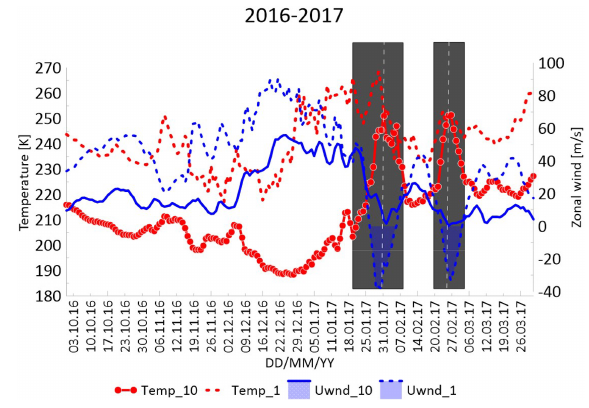
Figure 2. Zonal mean of the zonal wind at 10hPa (blue solid line) and 1hPa (blue dotted line) and zonal mean temperature at 10hPa (red solid line) and 1hPa (red dotted line) obtained from the ERA5 reanalysis dataset for October 2016 through March 2017.